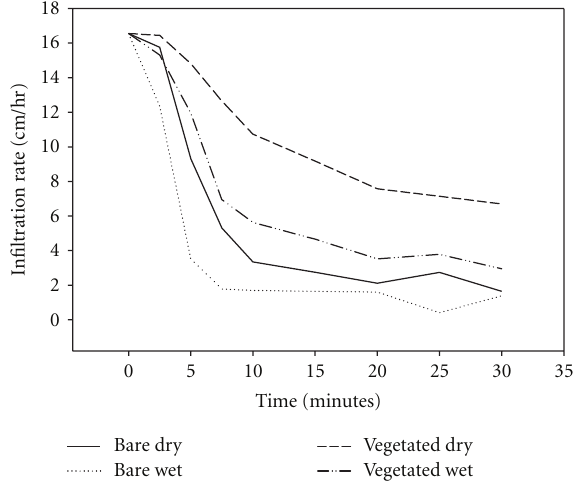
Figure 2: Infiltration flux for Stellar soil with 7Mg biosolidsha − 1 under bare dry, bare wet, vegetated dry, or vegetated wet conditions on the Sierra Blanca